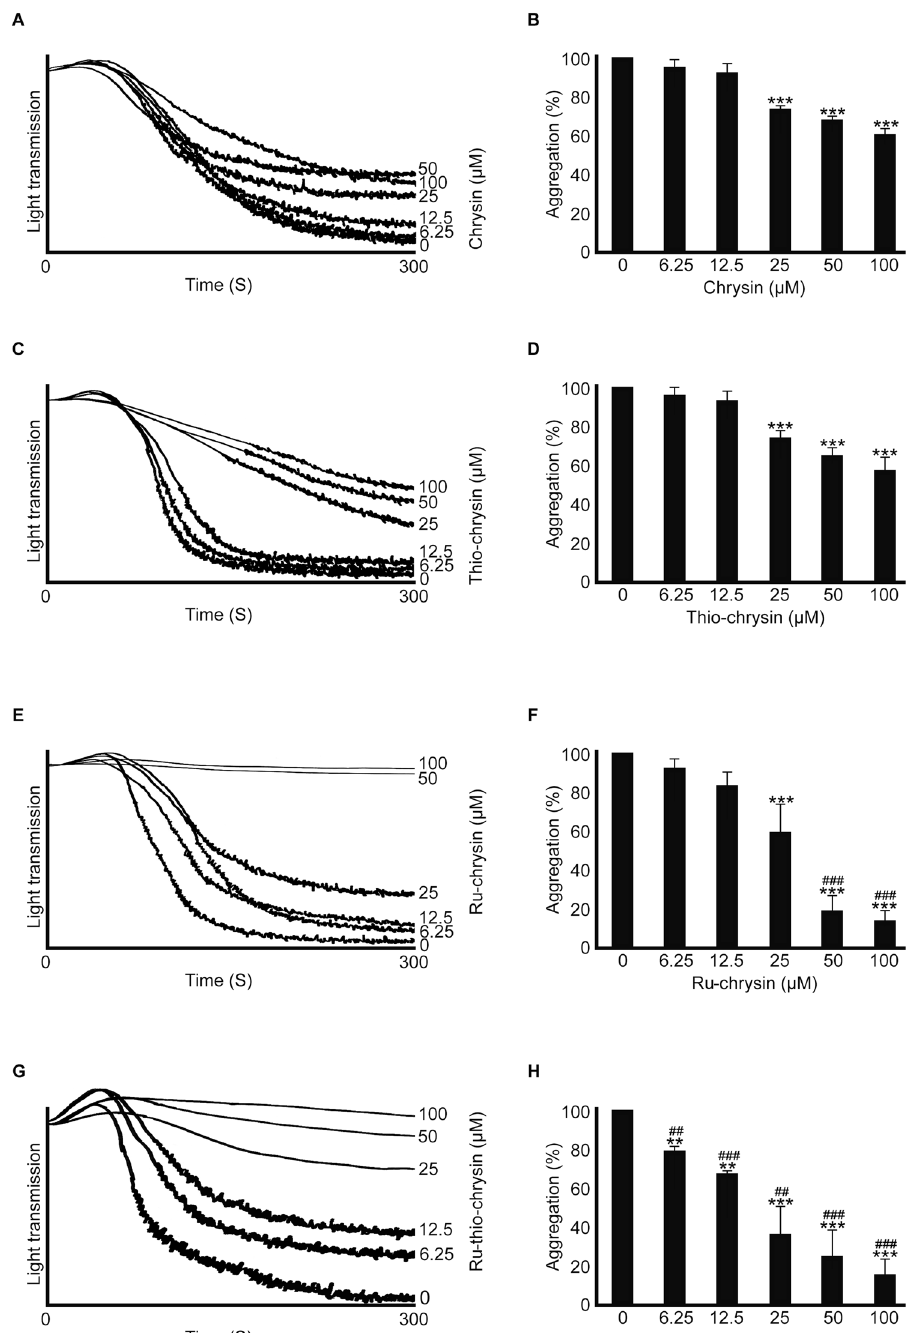
Figure 3. Impact of chrysin and its derivatives on platelet activation in platelet-rich plasma. Human platelet- rich plasma was treated with vehicle control [0.1% (v/v) DMSO] or a range of concentrations of chrysin ( A , B ), thio-chrysin ( C , D ), Ru-chrysin ( E , F ) and Ru-thio-chrysin ( G , H ) for 5 minutes prior to the addition of 0.5 μ g/ mL CRP-XL in an optical aggregometer. The platelet aggregation was monitored for 5 minutes. The traces shown are representative of three separate experiments. The maximum aggregation obtained with vehicle control at 5 minutes was taken as 100% to calculate the level of aggregation for chrysin and its derivatives-treated samples. Cumulative data represent mean ± S.D. (n = 3). * Indicates significance with respect to controls and # indicates significance with respect to the respective chrysin concentrations, p values shown ( ** ,## p < 0.01 and *** ,### p < 0.001) are as calculated by one-way ANOVA using Graphpad